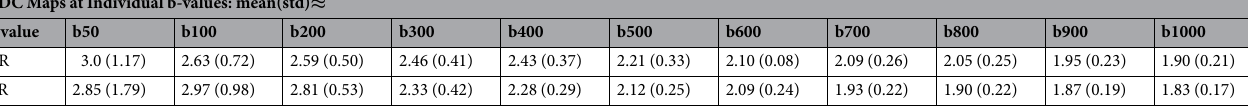
Table 2. A comparison example between a non-rejection (NR) and an acute rejection (AR) subjects based upon the mean and the standard deviation (std) values of the ADC maps alone at the 11 individual b-values.